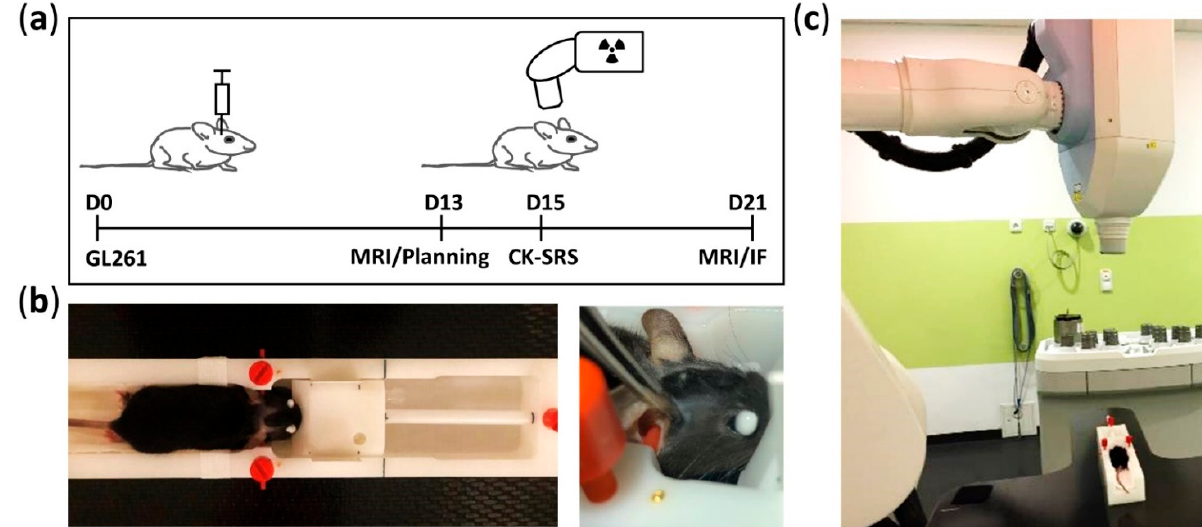
Figure 1. Timeline of experiment and details of mouse positioning during CK-SRS treatment. ( a ) Experimental timeline starting at day 0, defined as the date of the inoculation of GL261 glioma cells. At day 13, tumor growth was confirmed using MRI. Based on this acquired MRI dataset and the reference CT scan from one mouse, the treatment plan was prepared. Mice were subjected to CK-SRS treatment at day 15. At day 21, they were euthanized, and the final tumor volume was assessed by MRI. ( b ) Manufactured MRI frame allowing three-point head fixation and equipped with gold fiducial markers. To ensure reproducible and accurate irradiation, the setting position of the fixation frame was marked (black lines) accordingly. ( c ) Representative image of animal positioning on the fixation frame placed on the treatment table of the CyberKnife system (Accuray Inc., Sunnyvale, CA, USA) during SRS.